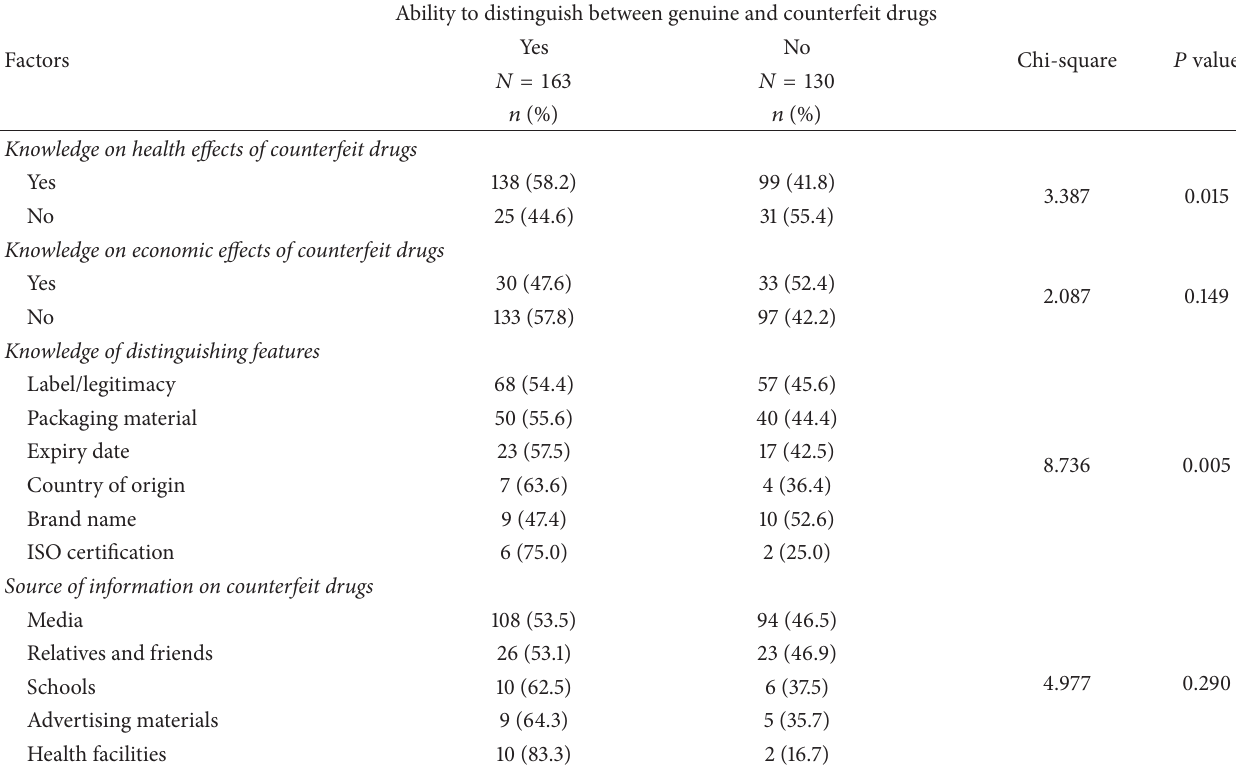
Table 4: Association of factors affecting ability to distinguish between genuine and counterfeit drugs.